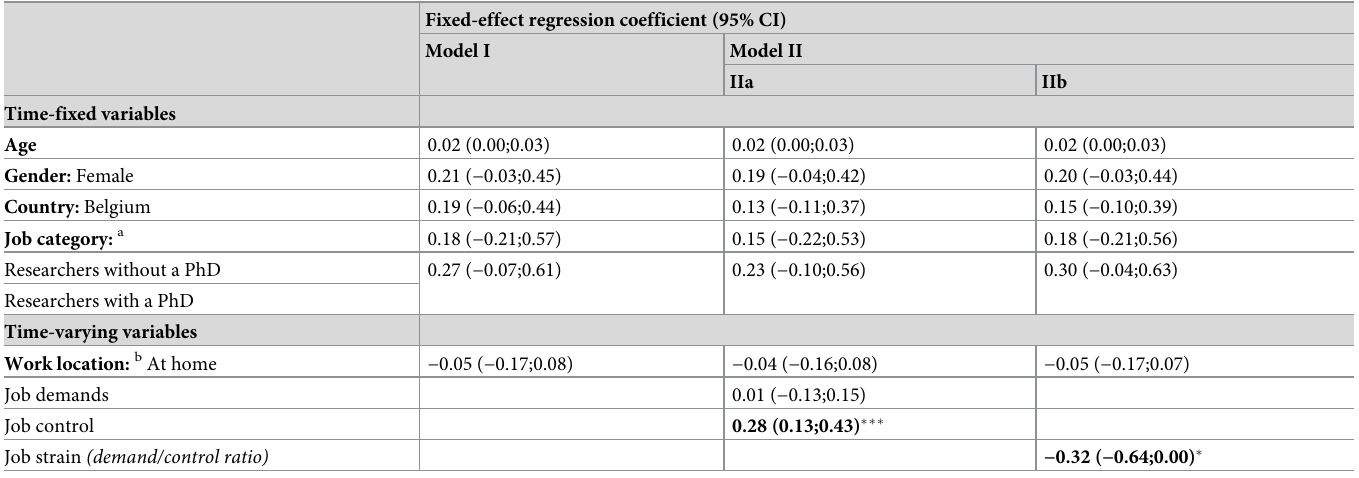
Table 2. Random-intercept models of the associations between day-to-day job demands t1 , job control t1 , job strain t1 , and work engagement t2 . [N = 55; number of item measurements = 2710; CI = confidence